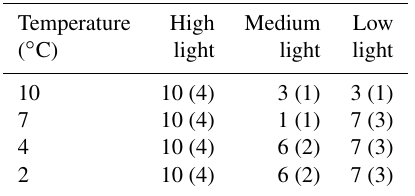
Table 3. Number of transects analysed with electron microprobe from each temperature and light level. Number of samples from each level in